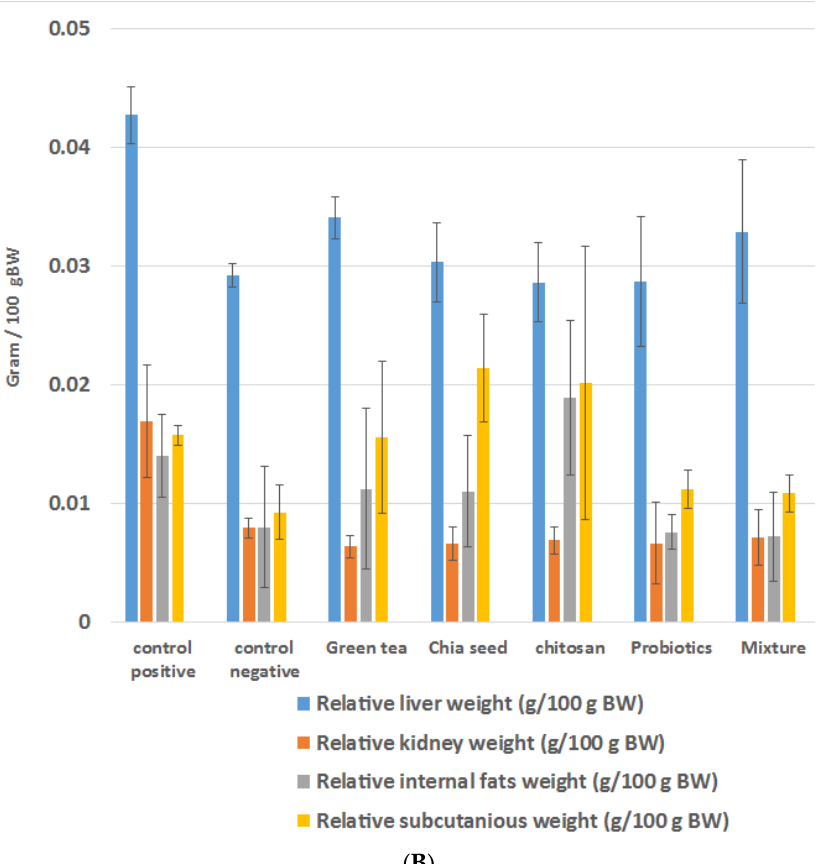
Figure 1. ( A ) Effect of prebiotics and probiotics on the weight of rats fed high-fat diet. ( B ) The body weight gain (BWG) at the end of experiment; the relative liver weights.